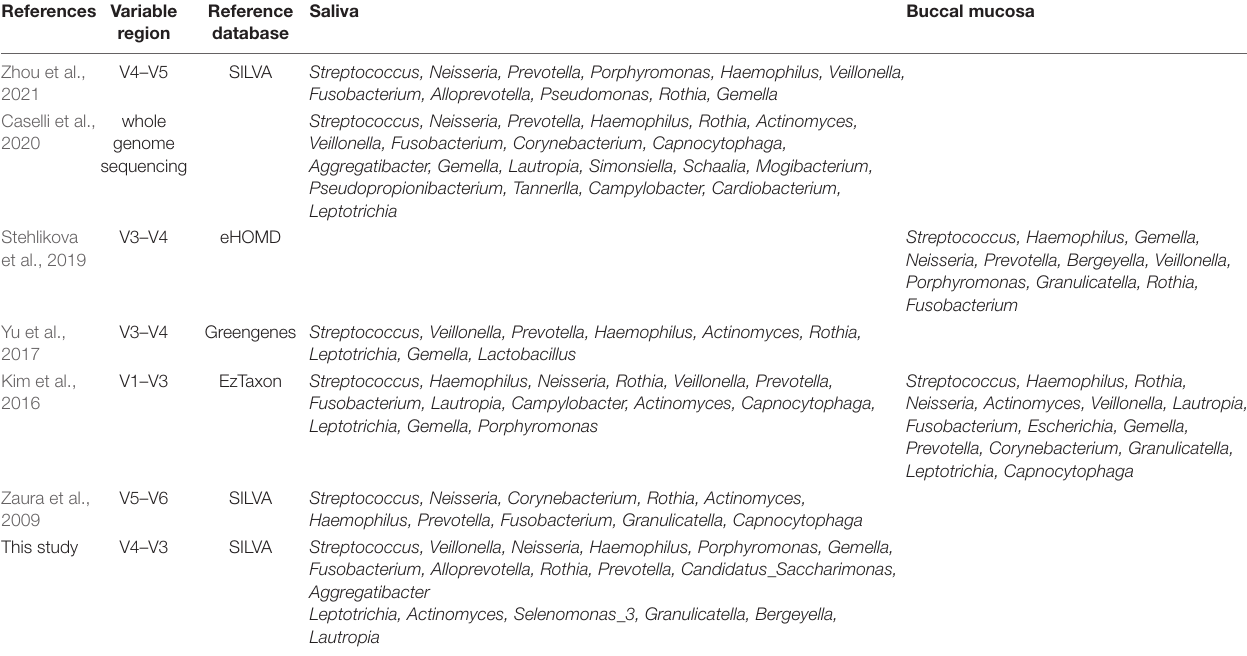
TABLE 3 | Comparison of the saliva and buccal mucosa microbiota composition of healthy